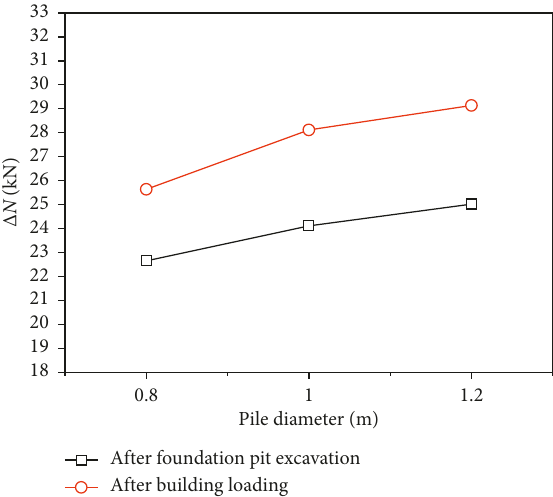
Figure 39: Difference between the additional normal forces.